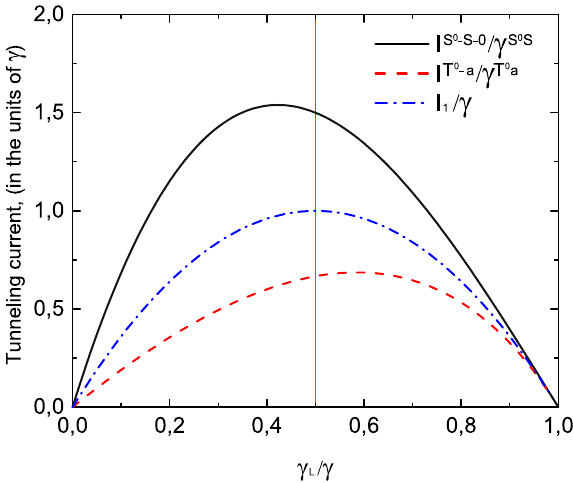
Figure 8. Tunneling current as a function of tunneling contact asymmetry γ T 0 a L /γ T 0 a γ S 0 S L /γ S 0 S γ S L /γ S ) for a single type of carriers I 1 /γ (blue dashed-dotted curve), for ( γ L /γ = = = 0 a channel I T 0 a /γ T 0 a (red dashed curve) and for the S 0 the T − 1 . Temperature is equal to 0.01 ε . curve). U / T ≫